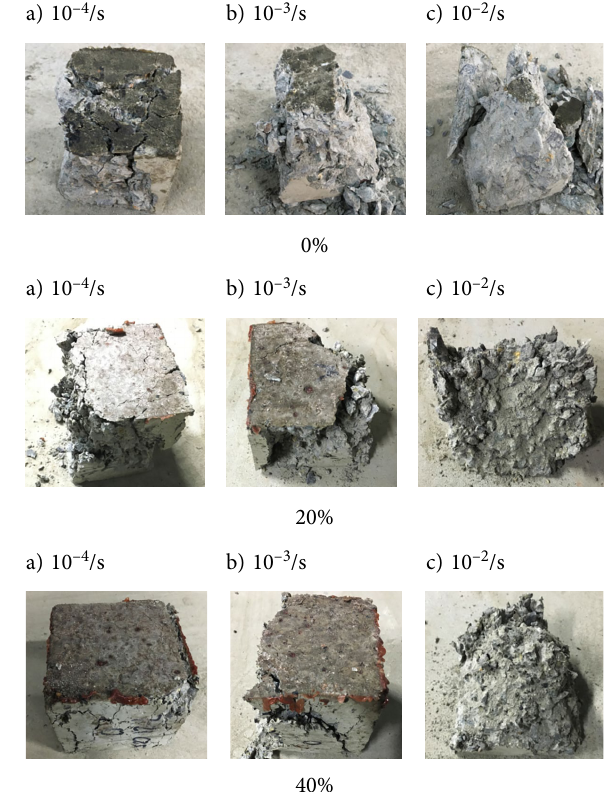
Figure 7. Compressive dynamic failure modes of rubber concrete with different substitution